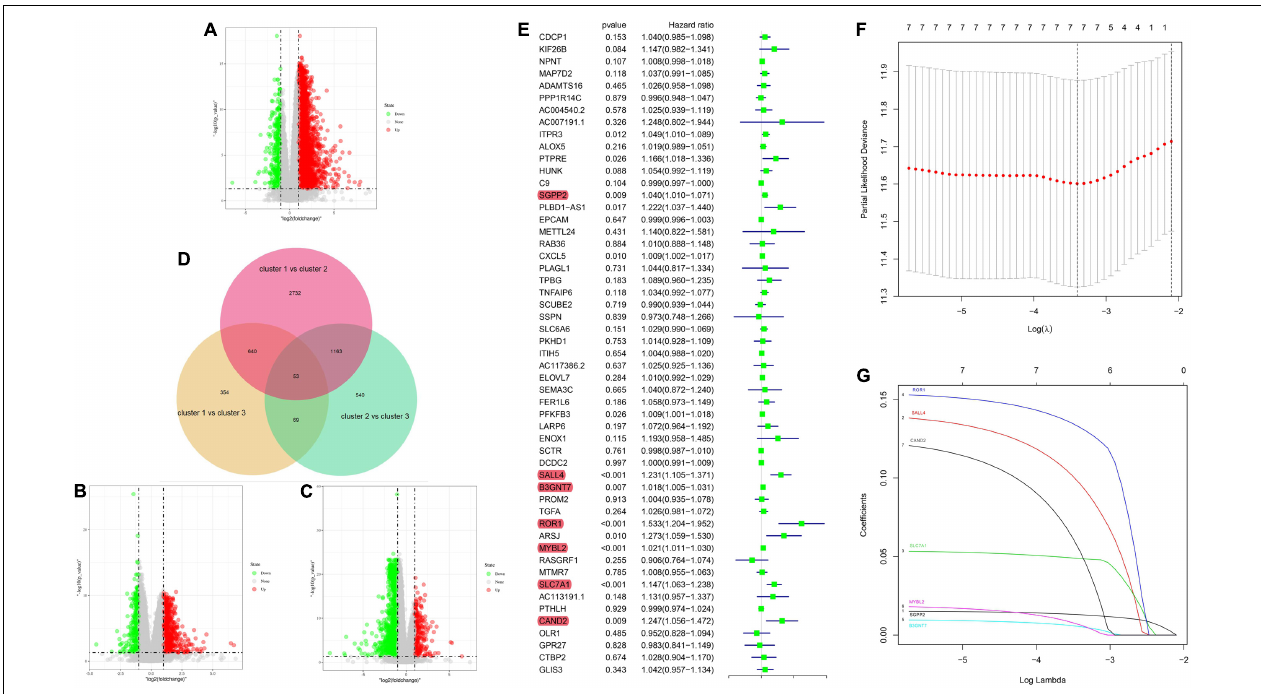
FIGURE 6 | 5mC score construction. Panels (A–C) show the volcano plots of the differentially expressed analysis. Panel (D) shows the Venn plot of three volcano plots. (E) Results of univariate Cox regression analysis. (F,G) Results of lasso regression